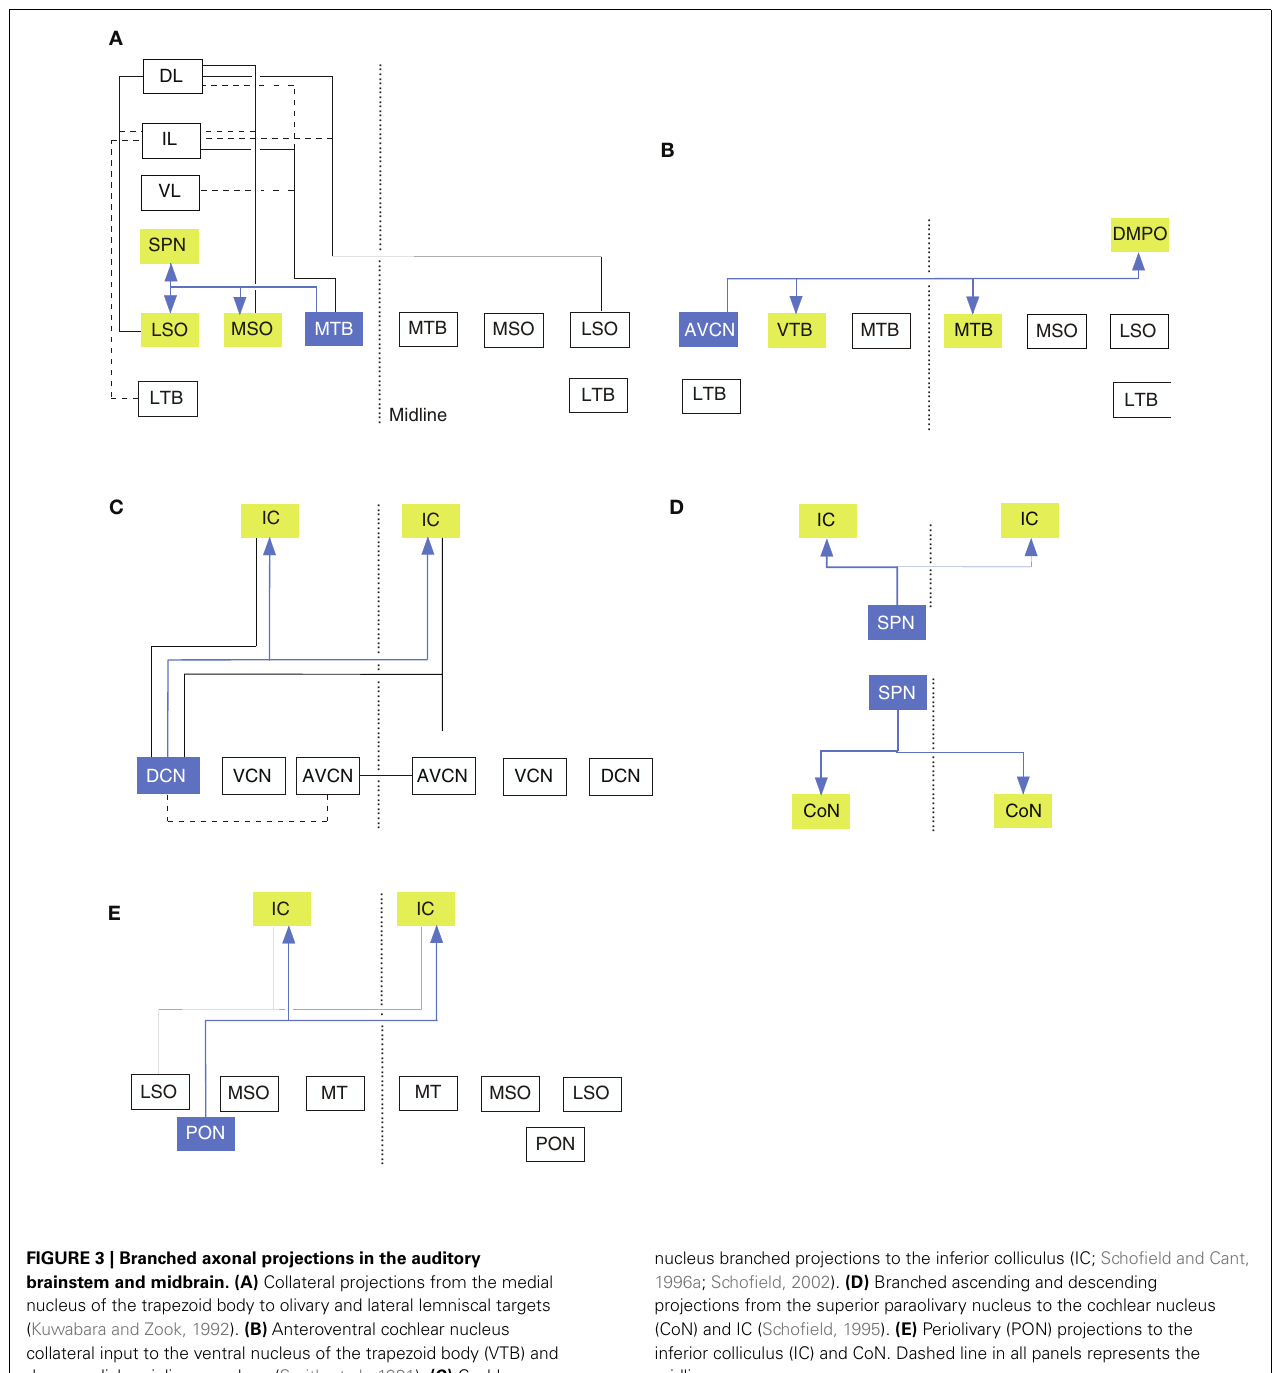
FIGURE 3 | Branched axonal projections in the auditory brainstem and midbrain. (A) Collateral projections from the medial nucleus of the trapezoid body to olivary and lateral lemniscal targets (Kuwabara and Zook, 1992). (B) Anteroventral cochlear nucleus collateral input to the ventral nucleus of the trapezoid body (VTB) and dorsomedial periolivary nucleus (Smith et al., 1991). (C) Cochlear